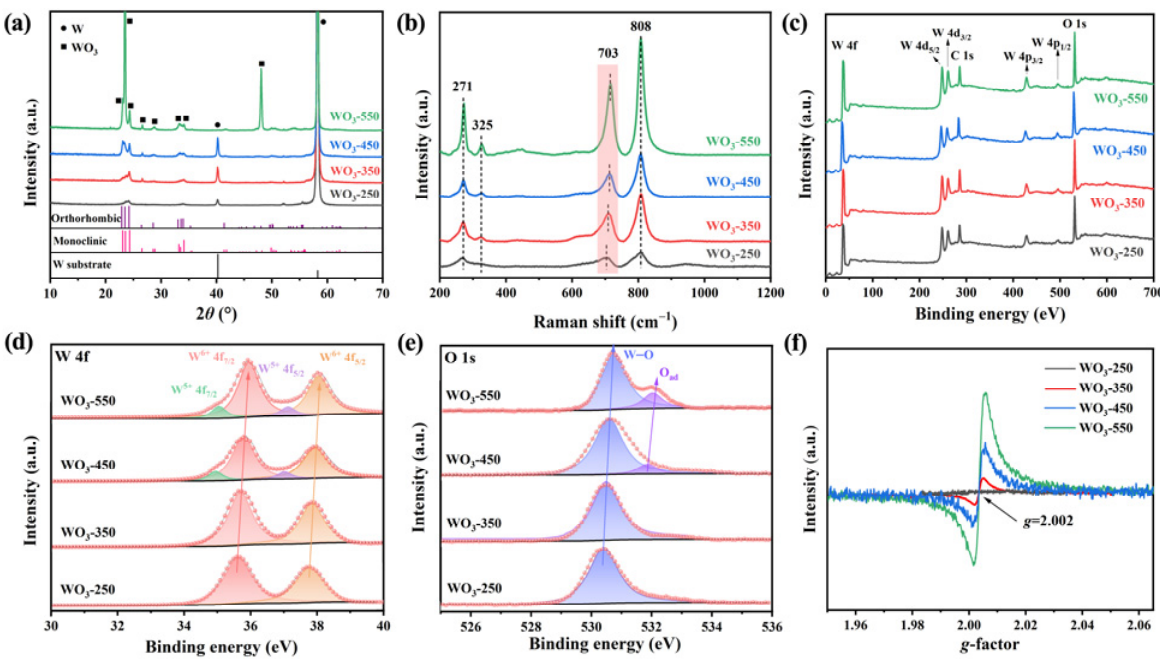
Fig. 2 (a) XRD patterns of different WO 3 photoelectrodes. (b) Raman spectra of all samples. (c) Survey XPS spectra. High-resolution XPS spectra of (d) W 4f and (e) O 1s. (f) EPR of all samples. Note: O ad is the adsorbed